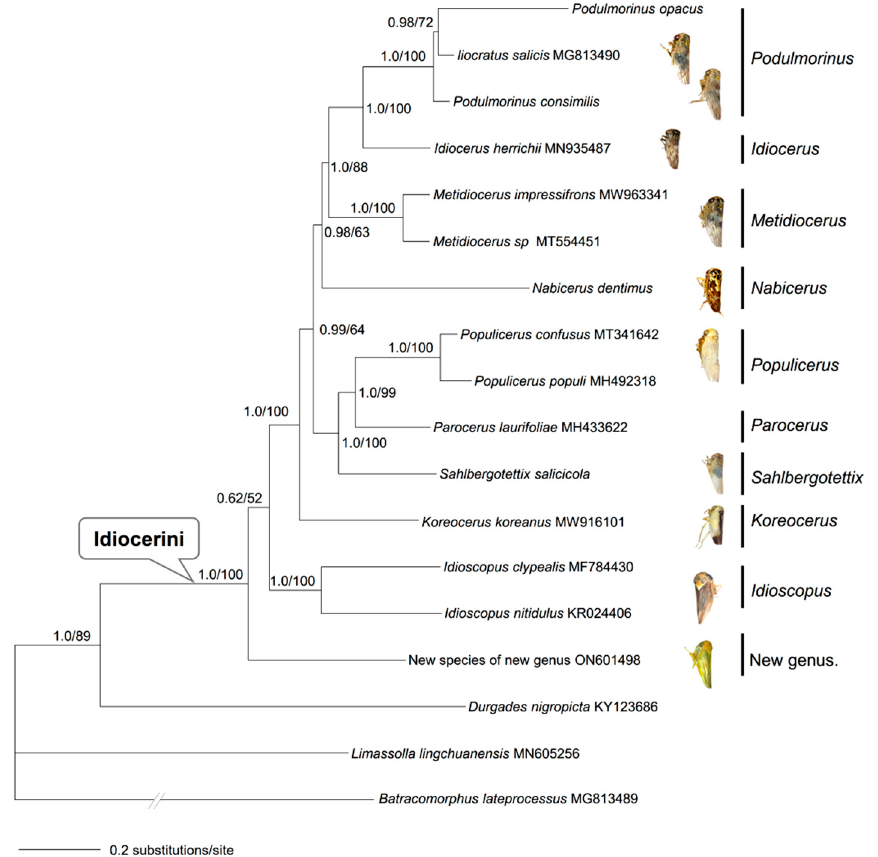
Figure 6. A 50% majority-rule consensus tree of the tribe Idiocerini inferred from the partitioned Bayesian analyses based on the concatenated 13 PCGs of 15 species and three outgroup taxa. Node numbers indicate Bayesian posterior probabilities and ML UFBoot values, respectively. Branch lengths represent the means of the posterior distribution. Genus/tribe assignments are listed.